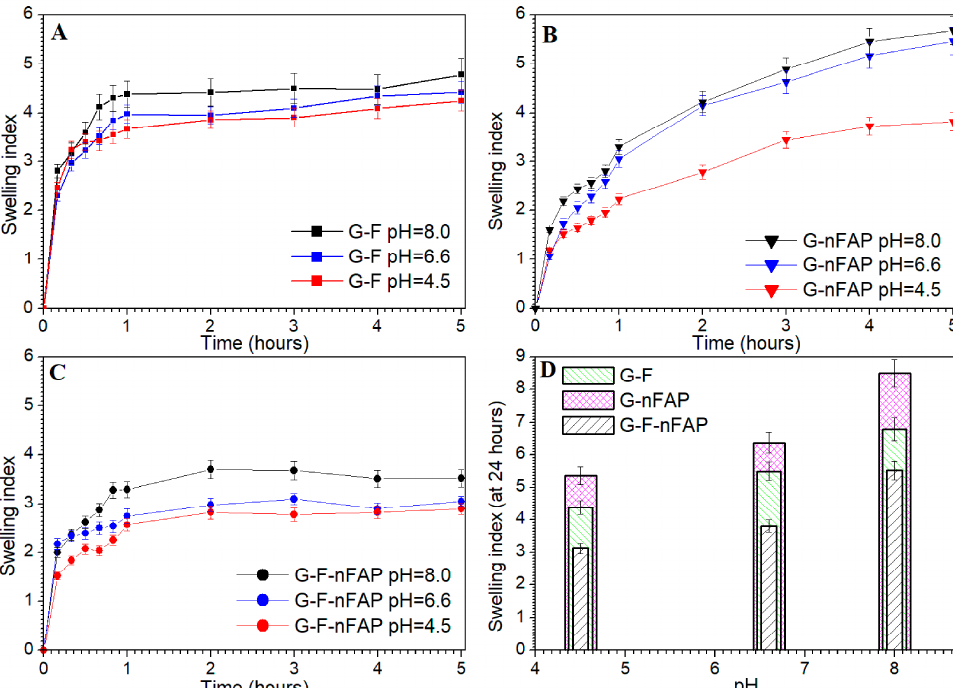
Figure 4. Swelling tests of the hydrogels in Fusayama–Meyer artificial saliva buffer (pH 4.5, 6.6, and 8.0) at 37 °C for G-F gel ( A ), G-nFAP gel ( B ) and G-F-nFAP gel ( C ) and a comparison of the swelling of the gels during the 24 h experiment ( D ) at different pH values.